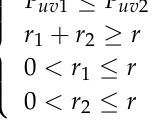
Figure 6. Relationship between r and ρ for γ .